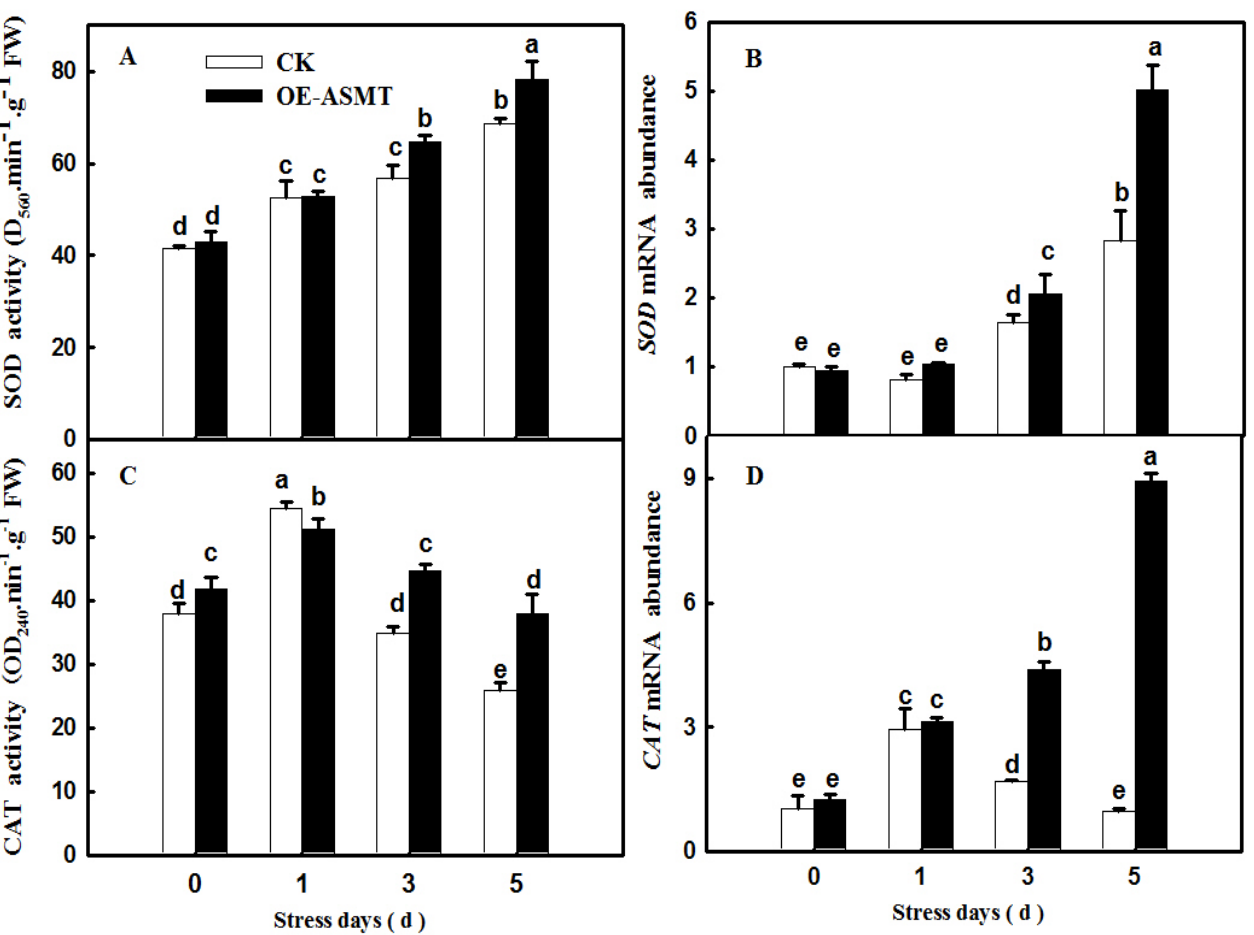
Figure 4. The effect of CsASMT transient overexpression on the activities and relative mRNA expressions of antioxidant enzyme in cucumber leaves under dark condition. ( A ) SOD activity; ( B ) the relative expression of SOD ; ( C ) CAT activity; ( D ) the relative expression of CAT . The CsASMT transient overexpression plants with two cotyledons were displaced into growth chambers and treated with dark condition (day/night temperature: 25 ◦ C/18 ◦ C). The cotyledons were collected for the determination of antioxidant enzyme activity and related mRNA at 0, 1, 3, and 5 days. All values shown are mean ± SD ( n = 3). a–e indicate that mean values are significantly different among samples ( p < 0.05).